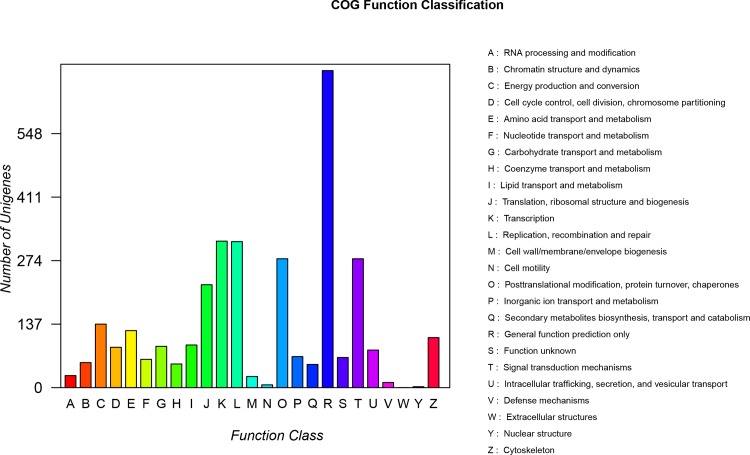
COG function classification of the unigenes.3,227 unigenes were classified into 25 COG categories.